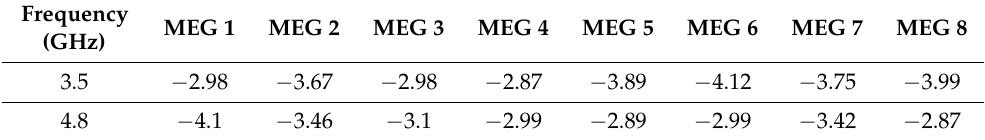
Figure 12. (a) ECC and (b) ergodic CC of MIMO antenna.